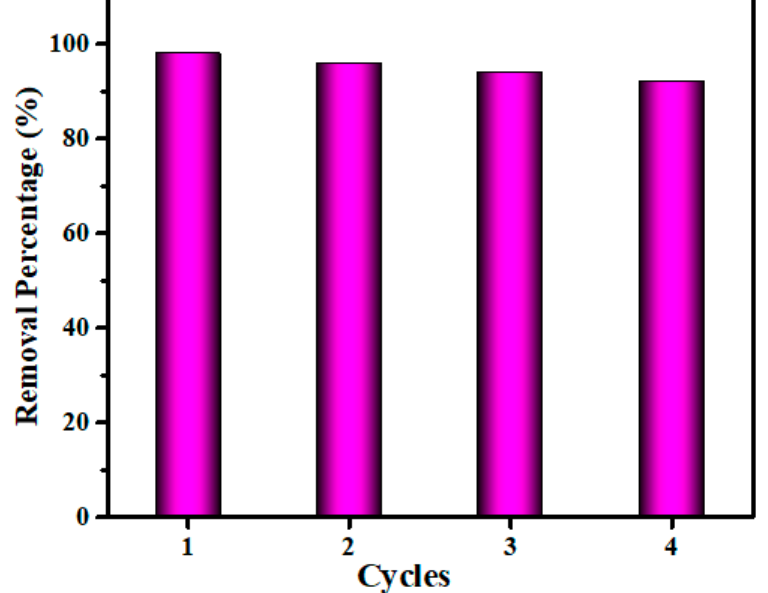
Figure 7. Reusability e ffi ciency of the V 2 O 5 -g-C 3 N 4